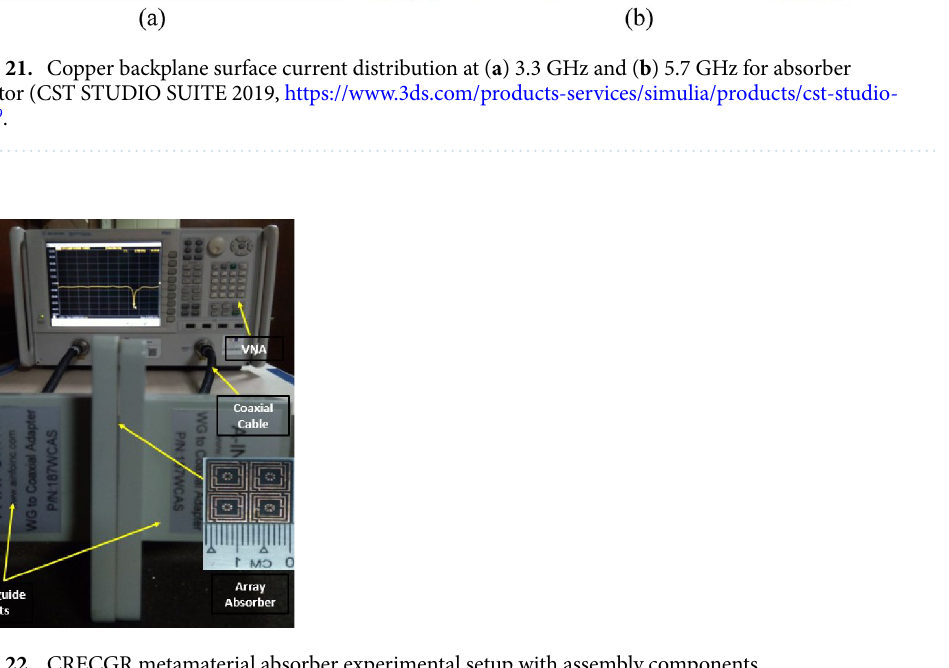
Figure 22. CRECGR metamaterial absorber experimental setup with assembly